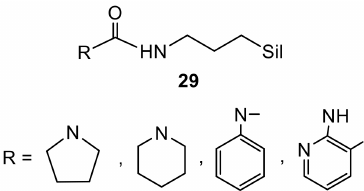
Figure 8. Chemical structures of silatranyl chemosensors ( 29 ) for the recognition acetate anion. Amide-tethered silatranes ( 30 ) contain Cu 2+ ion binding sites (Figure 9) [65]. Silatranes with acylthiourea ( 31 ) have the coordination ability to bind Cu 2+ , Cd 2+ , Hg 2+ ,and Pb 2+ ions (Figure 9) [66]. The UV-visible study of the Schiff-base-acetylene-functionalized